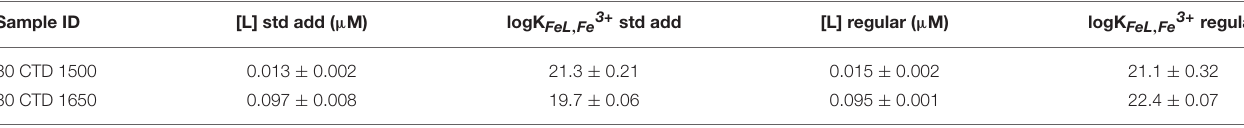
TABLE 2 | Comparison of [L] and logK FeL , Fe 3+ data obtained with a standard addition titration and a regular classic titration with 12 separate Fe additions and overnight equilibration. Sample ID